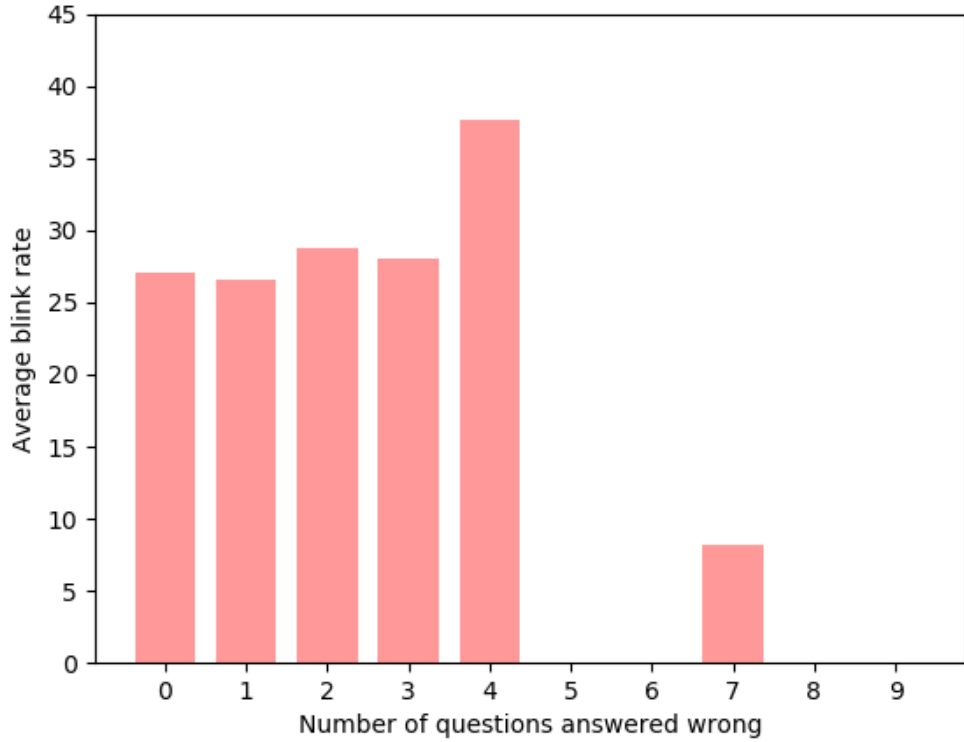
Figure 10. Average blink rate related to the number of mistakes made by the participants.